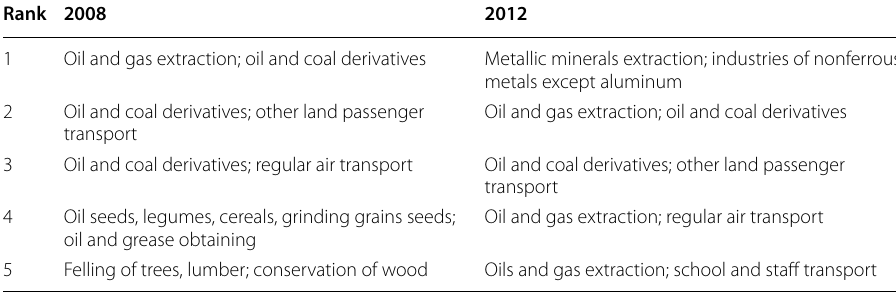
Table 1 Strongest connections in 2008 and 2012. Source: Results from authors calculations Rank 2008